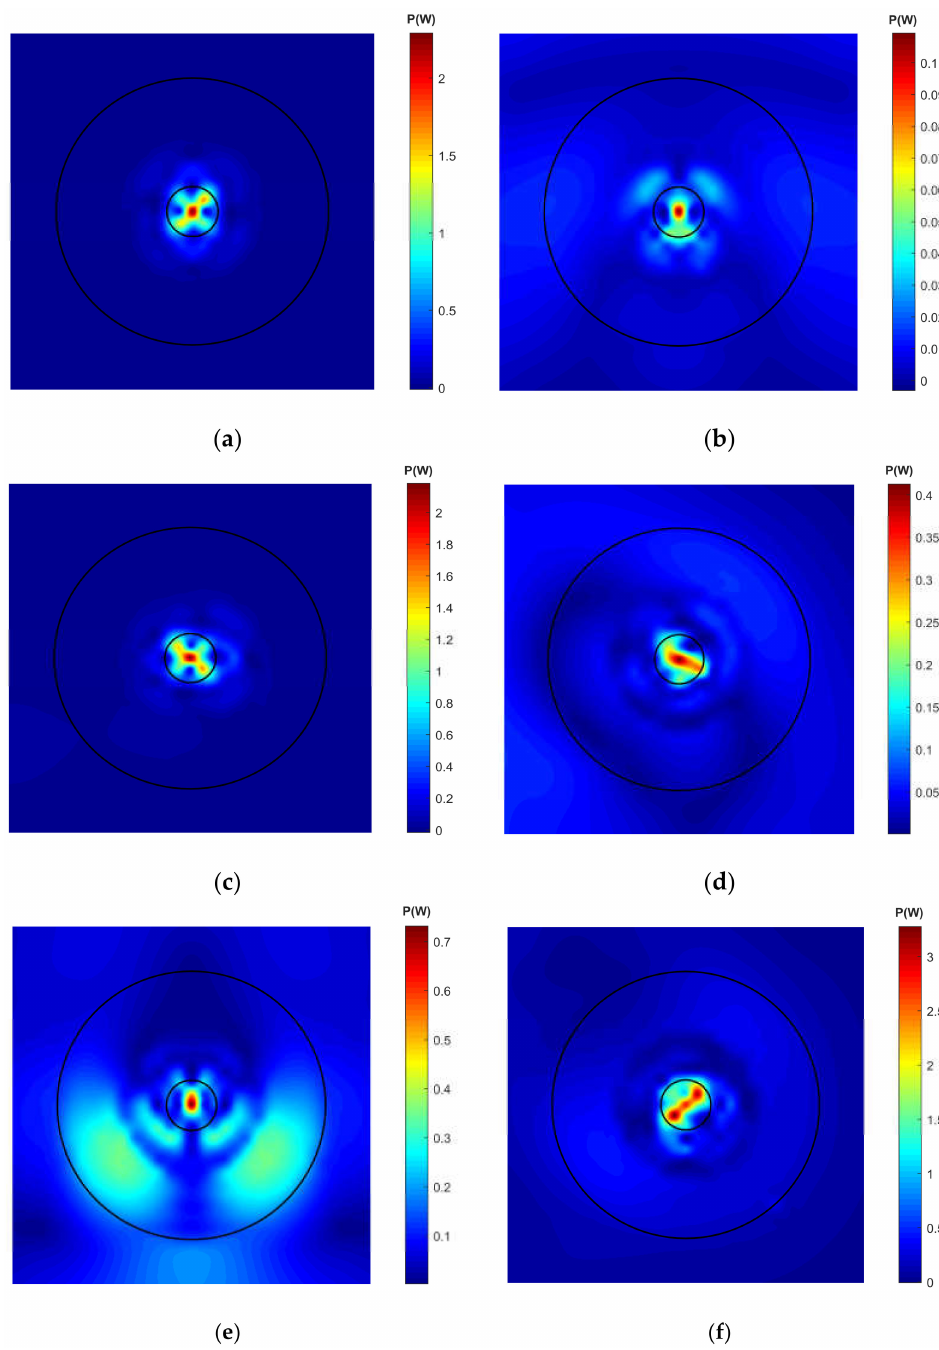
Figure A5. Structural intensity contours at an excitation frequency of 1050 Hz: ( a ) ABH(i) with BC 1, ( b ) ABH(ii) with BC 1, ( c ) ABH(iii) with BC 1, ( d ) ABH(i) with BC 2, ( e ) ABH(ii) with BC 2, ( f ) ABH(iii) with BC